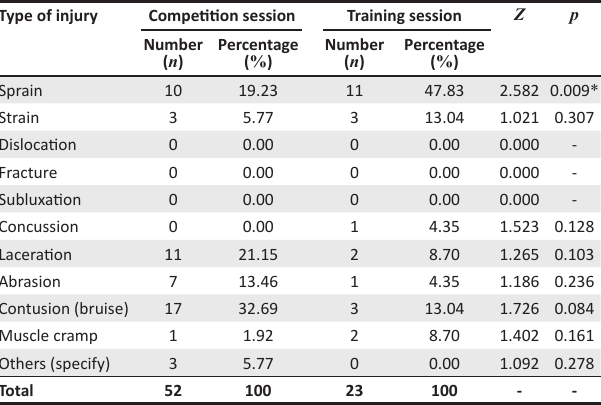
TABLE 5: Type of injury sustained during competition and training. Type of injury Competition session